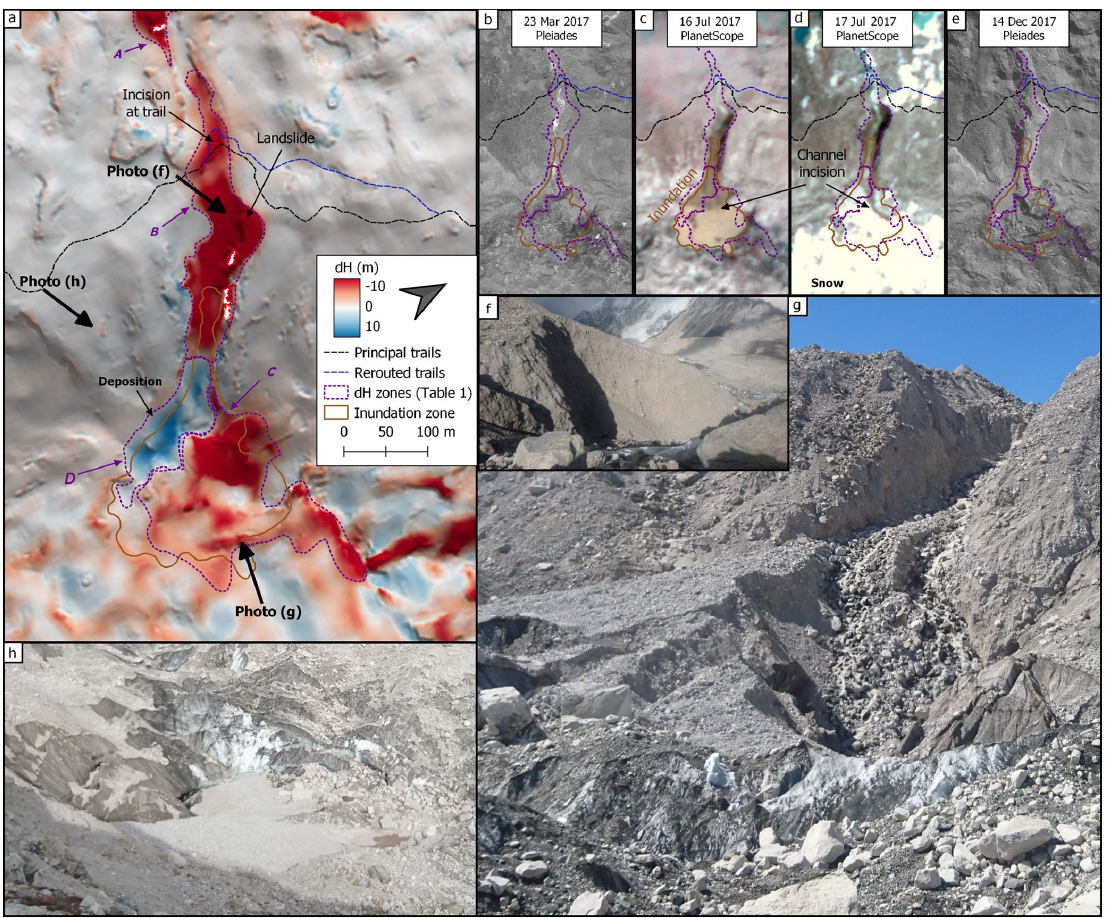
Figure 4. Flood-related geomorphic evidence at the base of the Changri Shar proglacial gorge. Surface elevation changes and locations of selected field photos, with hillshade of March Pléiades DEM as background (a) . Time series of satellite images documenting the blockage and incision of the stream inlet to Khumbu Glacier, with date and source specified in the text box (b–e) . A photograph taken in May 2018 of a fresh landslide scarp near the top of the proglacial gorge, the likely source for much of the debris (f) . A photograph of the deposit and incised channel, taken in October 2017 from the Khumbu Glacier surface (g) . A photograph of the deposit and concentric crevassing taken from the Khumbu moraine in October 2017 (h) . All photographs taken by the